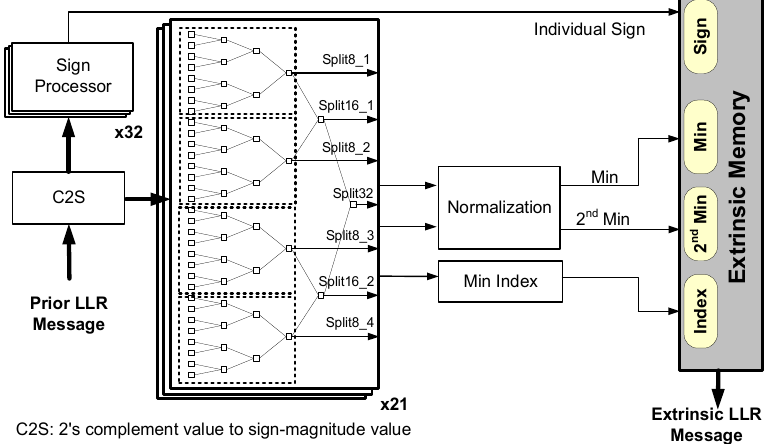
Figure 20. Reconfigurable CNU architecture.